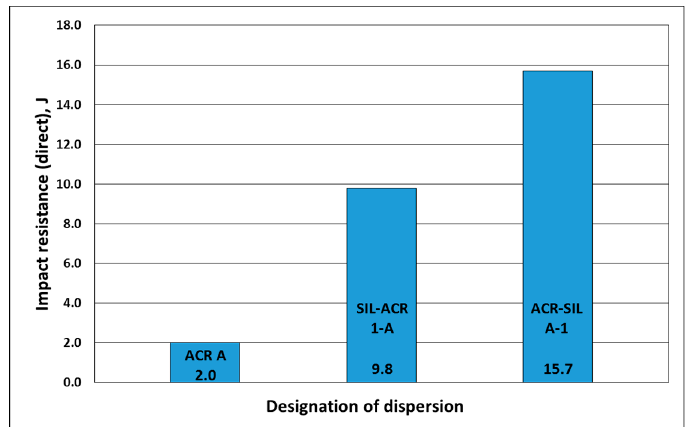
Figure 15. Comparison of impact resistance (direct) determined for coatings obtained from starting acrylic/styrene copolymer dispersion (ACR A) and hybrid dispersions ACR-SIL A-1 and SIL-ACR 1-A having the same composition of SIL and ACR parts.